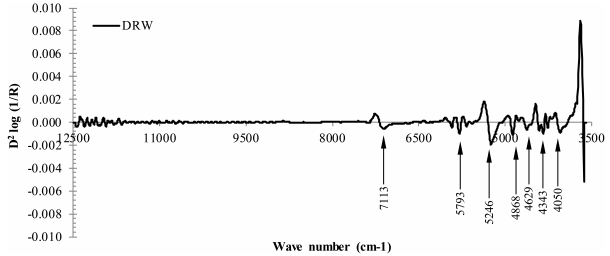
Fig. 4. Average second-derivative of NIR spectra of DRW obtained using an FT-NIR spectrometer over the wave number region 12,500 – 4,000 cm (cid:1) 1